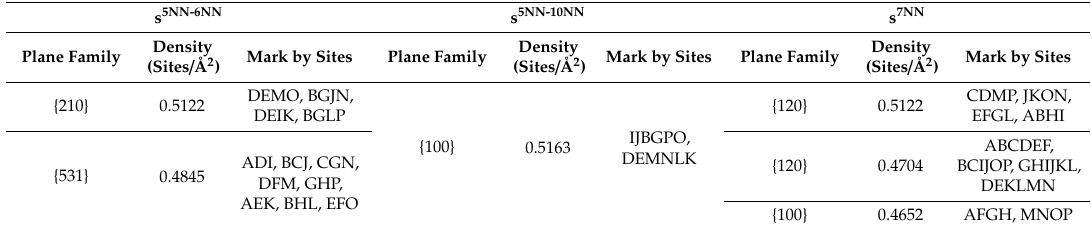
Table 3. The densest planes (DPs) of s 5NN-6NN , s 5NN-10NN , and s 7NN.